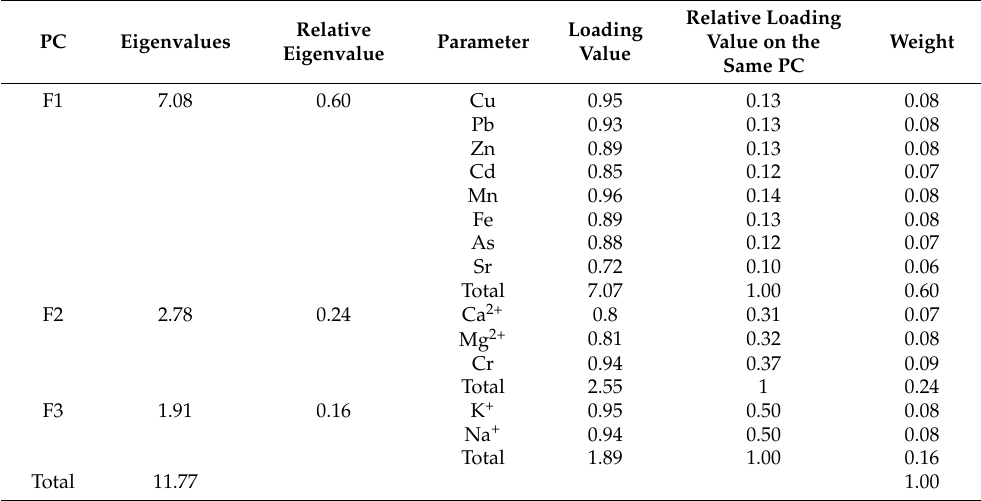
Table 5. Hazard quotient and hazard index for each heavy metal in the Sidi River’s karst basin. Relative Loading Relative Loading PC Eigenvalues Parameter Value on the Weight Eigenvalue Value Same PC F1 7.08 0.60 Cu 0.95 0.13 0.08 Pb 0.93 0.13 0.08 Zn 0.89 0.13 0.08 Cd 0.85 0.12 0.07 Mn 0.96 0.14 0.08 Fe 0.89 0.13 0.08 As 0.88 0.12 0.07 Sr 0.72 0.10 0.06 Total 7.07 1.00 0.60 F2 2.78 0.24 Ca 2+ 0.8 0.31 0.07 Mg 2+ 0.81 0.32 0.08 Cr 0.94 0.37 0.09 Total 2.55 1 0.24 F3 1.91 0.16 K + 0.95 0.50 0.08 Na + 0.94 0.50 0.08 Total 1.89 1.00 0.16 Total 11.77